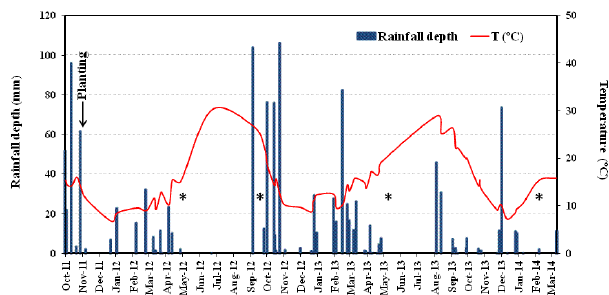
Figure 2. Temporal variability in rainfall and temperature from Oc- tober 2011 to March 2014. The ∗ symbol indicates the plant moni- toring